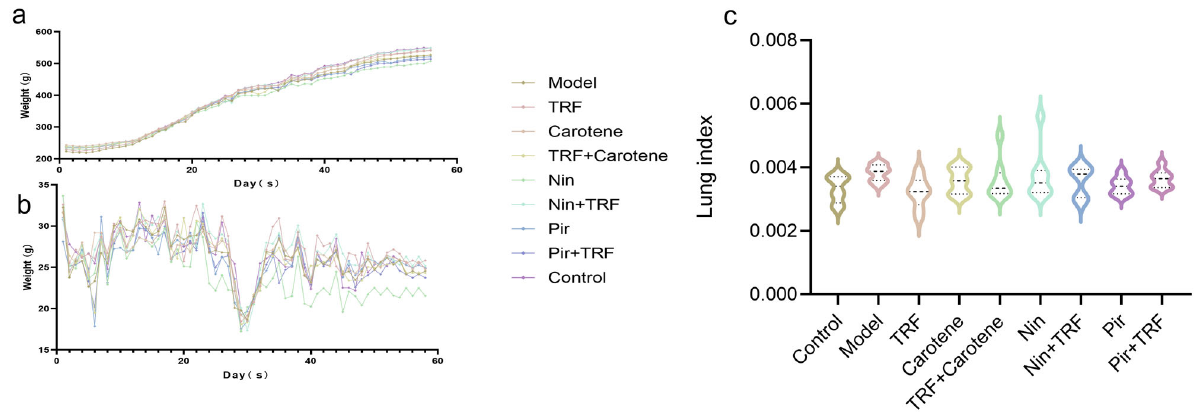
Figure 1. Effects on weight (g) and feed intake (g) of TRF: ( a ) Body weight changes in rat groups recorded every other day during the experiment ( n = 15); ( b ) Feed intake changes in rat groups recorded every other day during the experiment ( n = 15); ( c ) Lung/body weight ratios of rats on the last day of the experiment ( n = 15). Data are expressed as the mean ± SD. There were no significant differences between the groups.